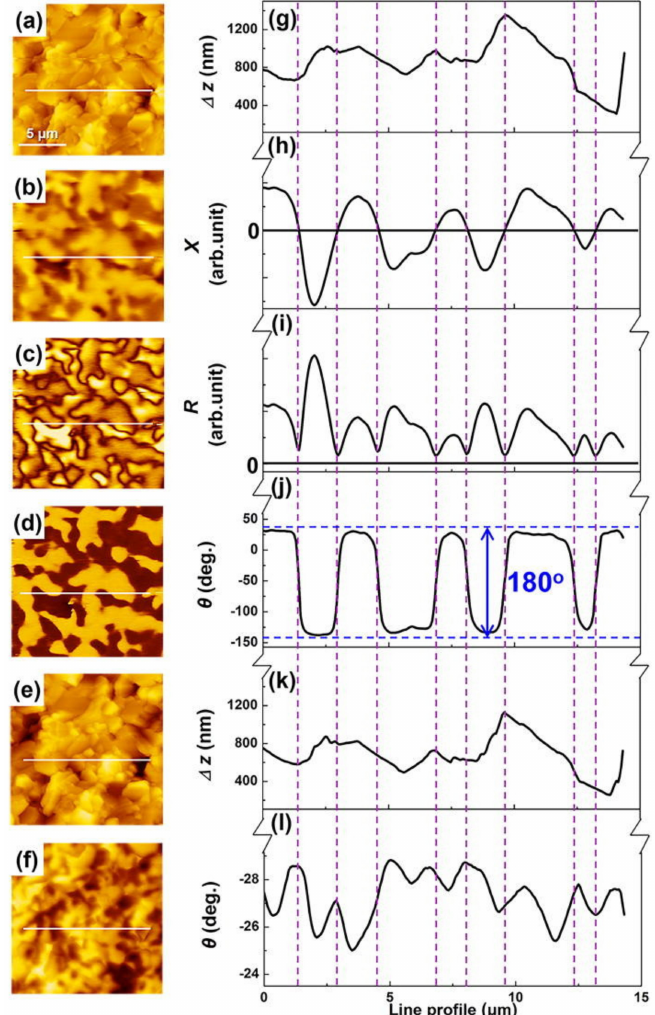
Figure 9. ( a ) A-MFM topographic image, ( b ) A-MFM in-phase X image (in-phase output of lock-in amplifier), and ( c ) A-MFM amplitude R image (amplitude output of lock-in); ( d ) A-MFM phase image of SrF measured by FeCo-GdO x superparamagnetic tip; ( e ) topographic image and ( f ) phase image of the conventional MFM of the SrF measured by FePt hard-magnetic tip and their corresponding line profiles ( g – l ). Reprinted from [89] and with permission from AIP Publishing